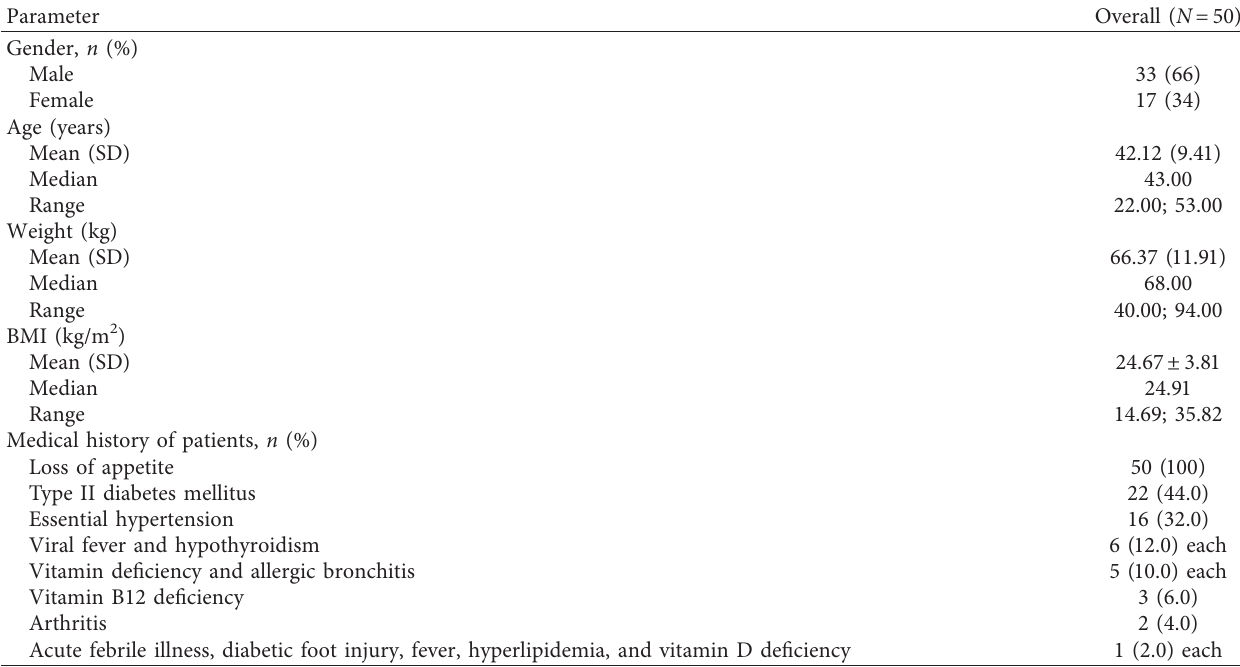
Figure 1: Description of study activities. CNAQ, Council on Nutrition Appetite Questionnaire. Table 1: Demographics and patient baseline characteristics (safety population) ∗